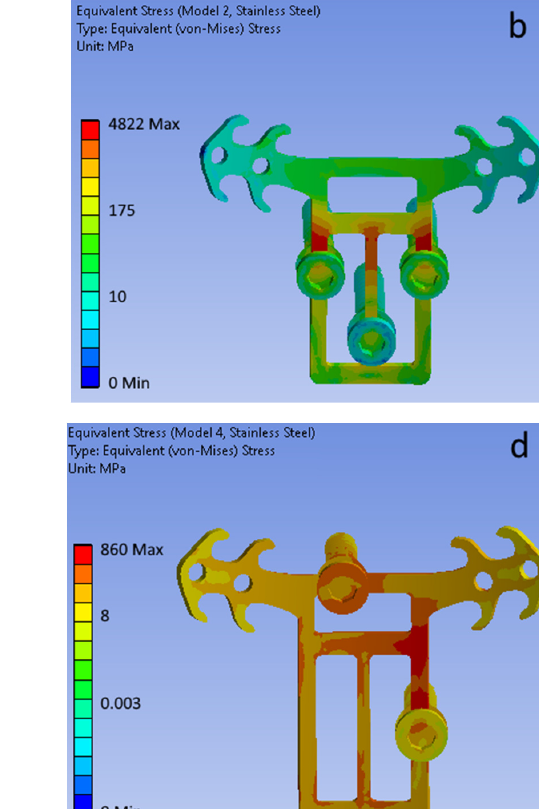
Figure 9. Equivalent stress field for ( a )–( d ) mini-implant configurations (POD material—stainless steel). ( a ) Model 1. ( b ) Model 2. ( c ) Model 3. ( d ) Model 4.